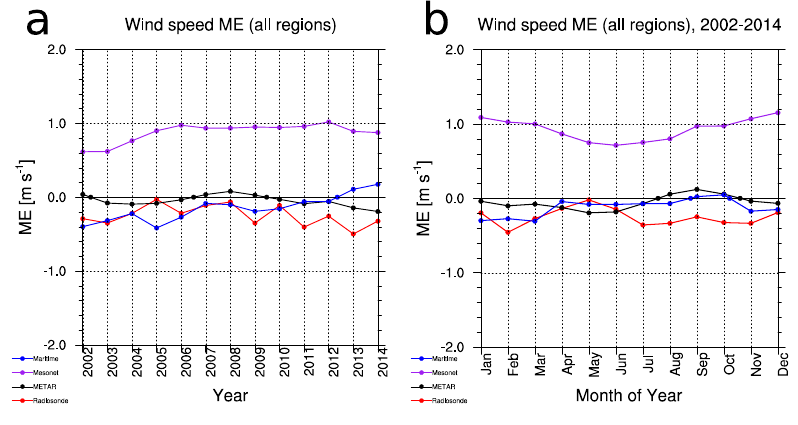
Figure 10. Root mean squared error over the entire domain, for maritime (blue), mesonet (purple), METAR (black), and radiosonde (red) wind speed, spanning September 2002–December 2014. RMSE is displayed as ( a ) an annual average, and ( b ) an average annual cycle.